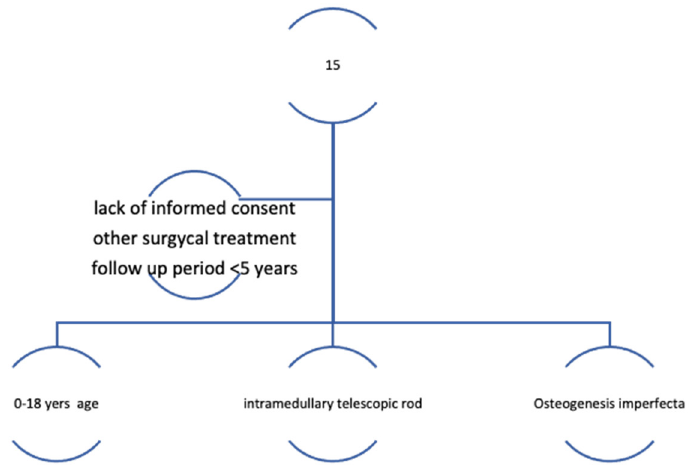
Figure 2. Flow chart of inclusion and exclusion criteria.